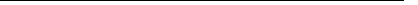
P E i ) 2 = ( . It represents i EE ;0 s